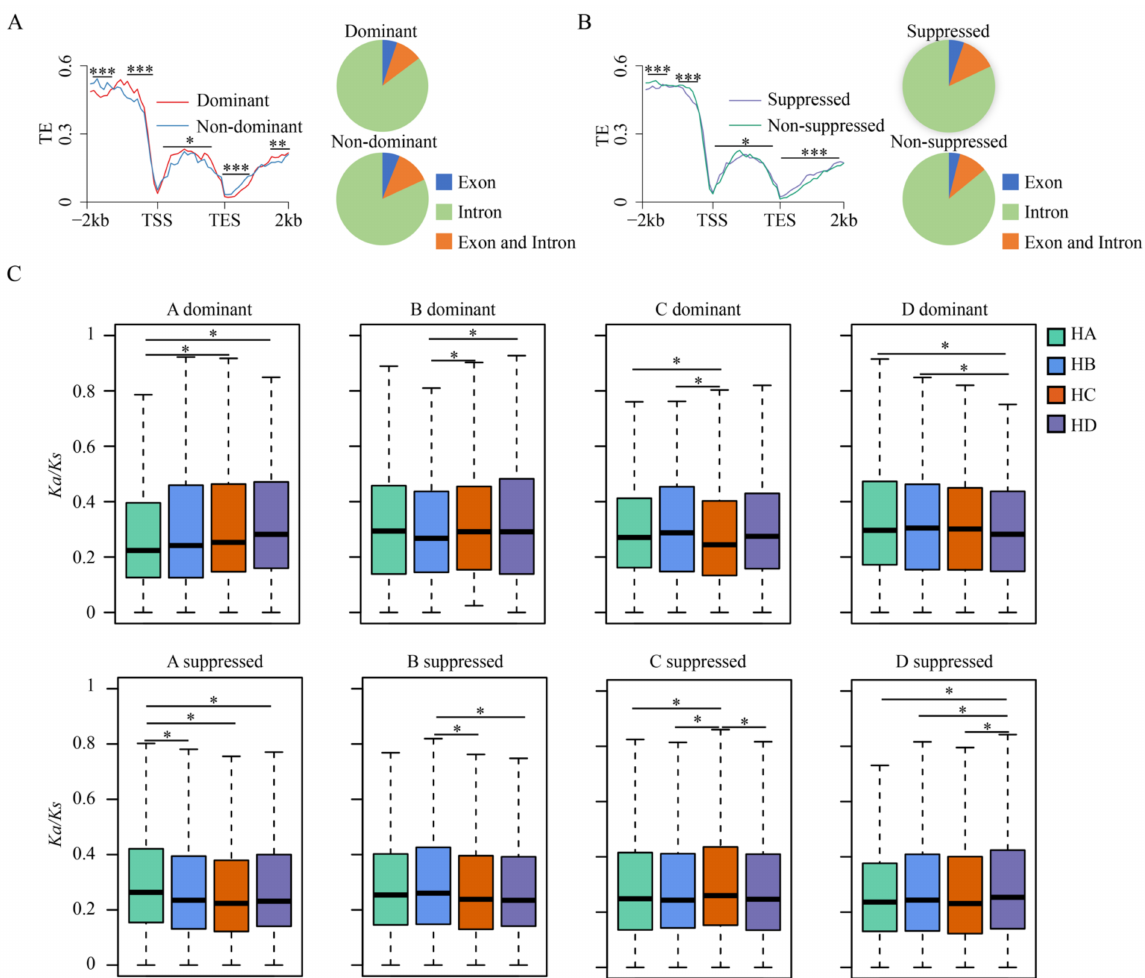
Figure 3. Transposable elements distribution and election pressure analysis. ( A ) Distribution of transposable elements between dominant and non-dominant alleles, and proportion of TEs at intron, exon or intron/exon regions. ( B ) Distribution of transposable elements between suppressed and non-suppressed alleles ( C ) Ka/Ks values distribution of tetrad alleles of each expression categories. The differences were tested using the Mann–Whitney test. * p value < 0.05, ** p value < 0.01, *** p value <